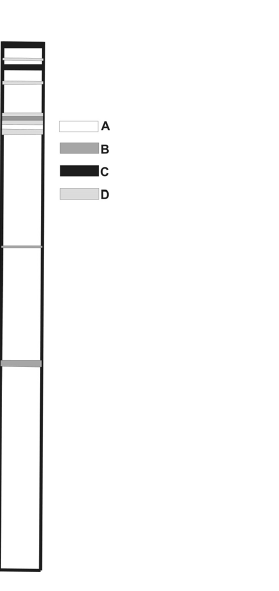
Figure 6. Share Stelvio Borehole (SSB) stratigraphy. Legend: (a) facies a (massive dolostone from grey to pinky grey); (b) fa- cies b (white dolostone); (c) facies c (black stratified limestone); (d) facies d (light brown